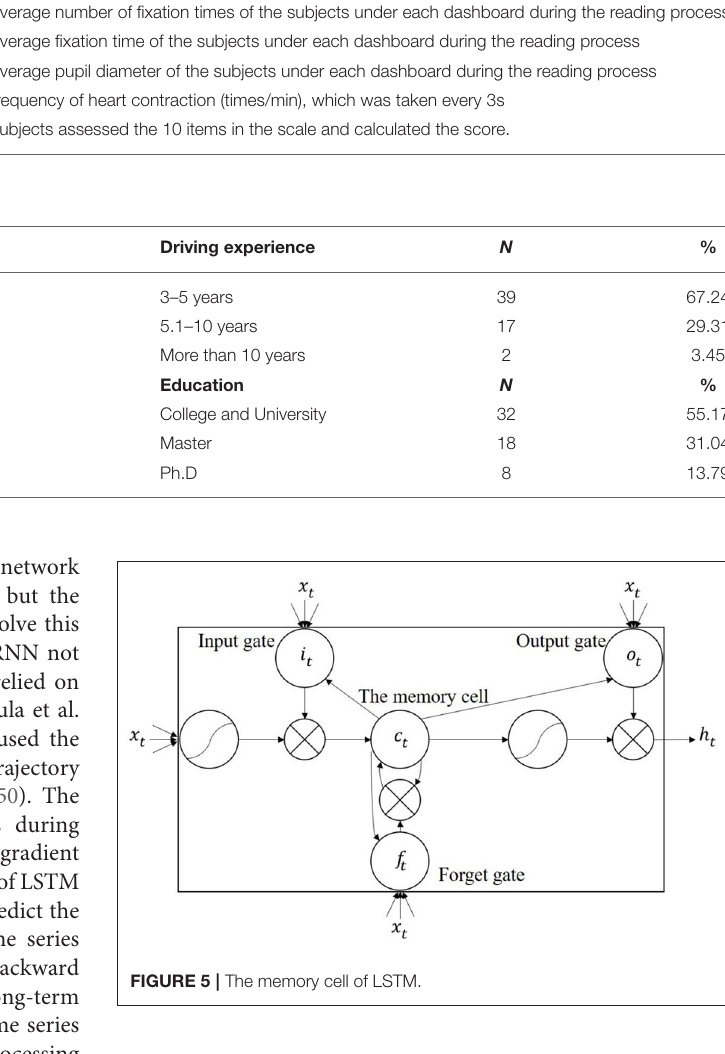
HR variation. Figure 5 described the memory unit of the LSTM network (52). For the input vector sequence x = ( x 1 , . . . , x T ) in the recurrent neural network, the hidden layer vector sequence h = ( h 1 , . . . , h T ) and the output vector sequence y = ( y 1 , . . . , y T